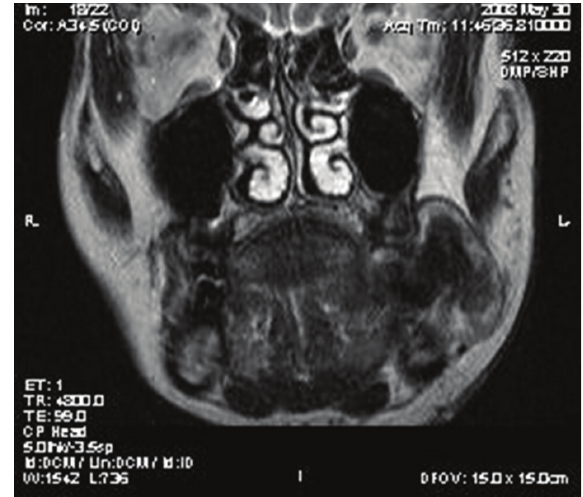
Figure 1: Intraoral photograph.